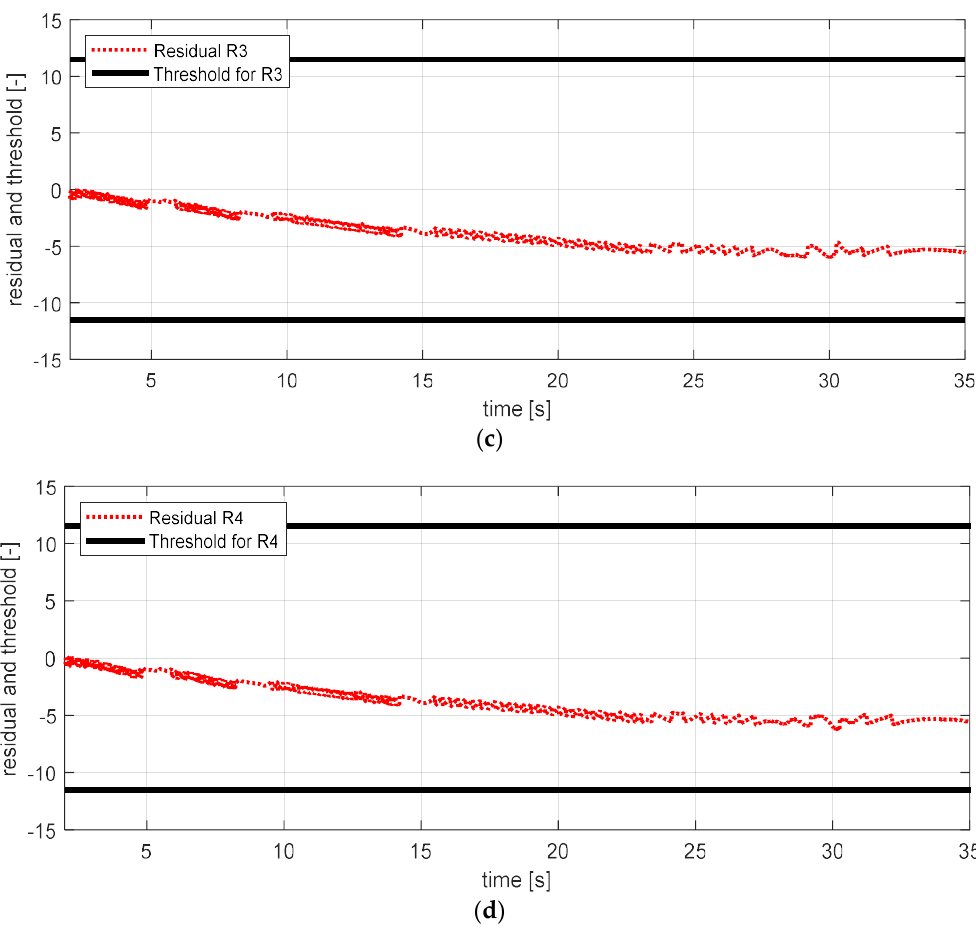
Figure 17. FDI (fault detection and isolation) simulation result for yaw rate sensor (normal). ( a ) Residual 1 and threshold; ( b ) residual 2 and threshold; ( c ) residual 3 and threshold; ( d ) residual 4 and threshold.